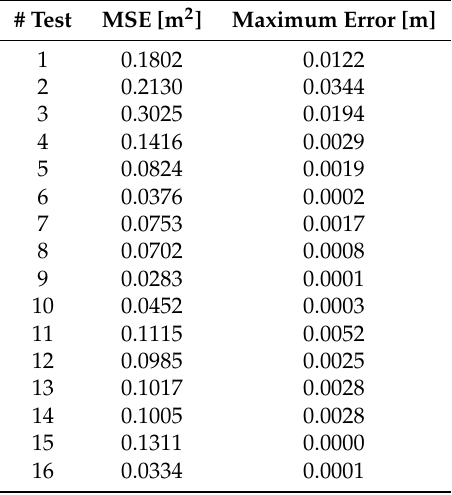
Table 6. Error results for the real forward tests.